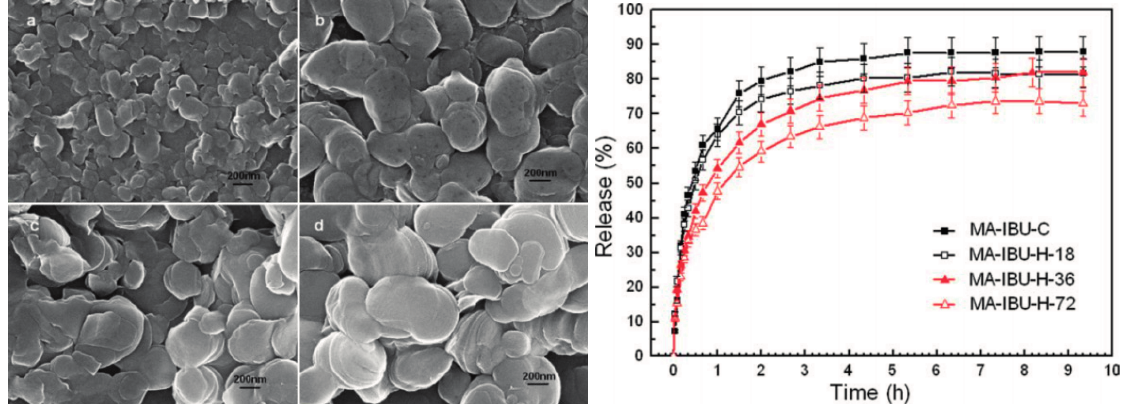
Figure 10. ( Left ) SEM images of MA-IBU - C ( a ) and MA-IBU - H -i samples with i = 18 h ( b ), 36 h ( c ) and 72 h ( d ); ( Right ) Release profiles of IBU from MA - IBU - C ( ■ ), MA - IBU - H - 18 ( □ ), MA - IBU - H - 36 ( ▲ ) and MA-IBU-H-72 ( ∆ ) in pH 7.45 PBS. Modified with permission from [43] (Copyright 2010 American Institute of Chemical